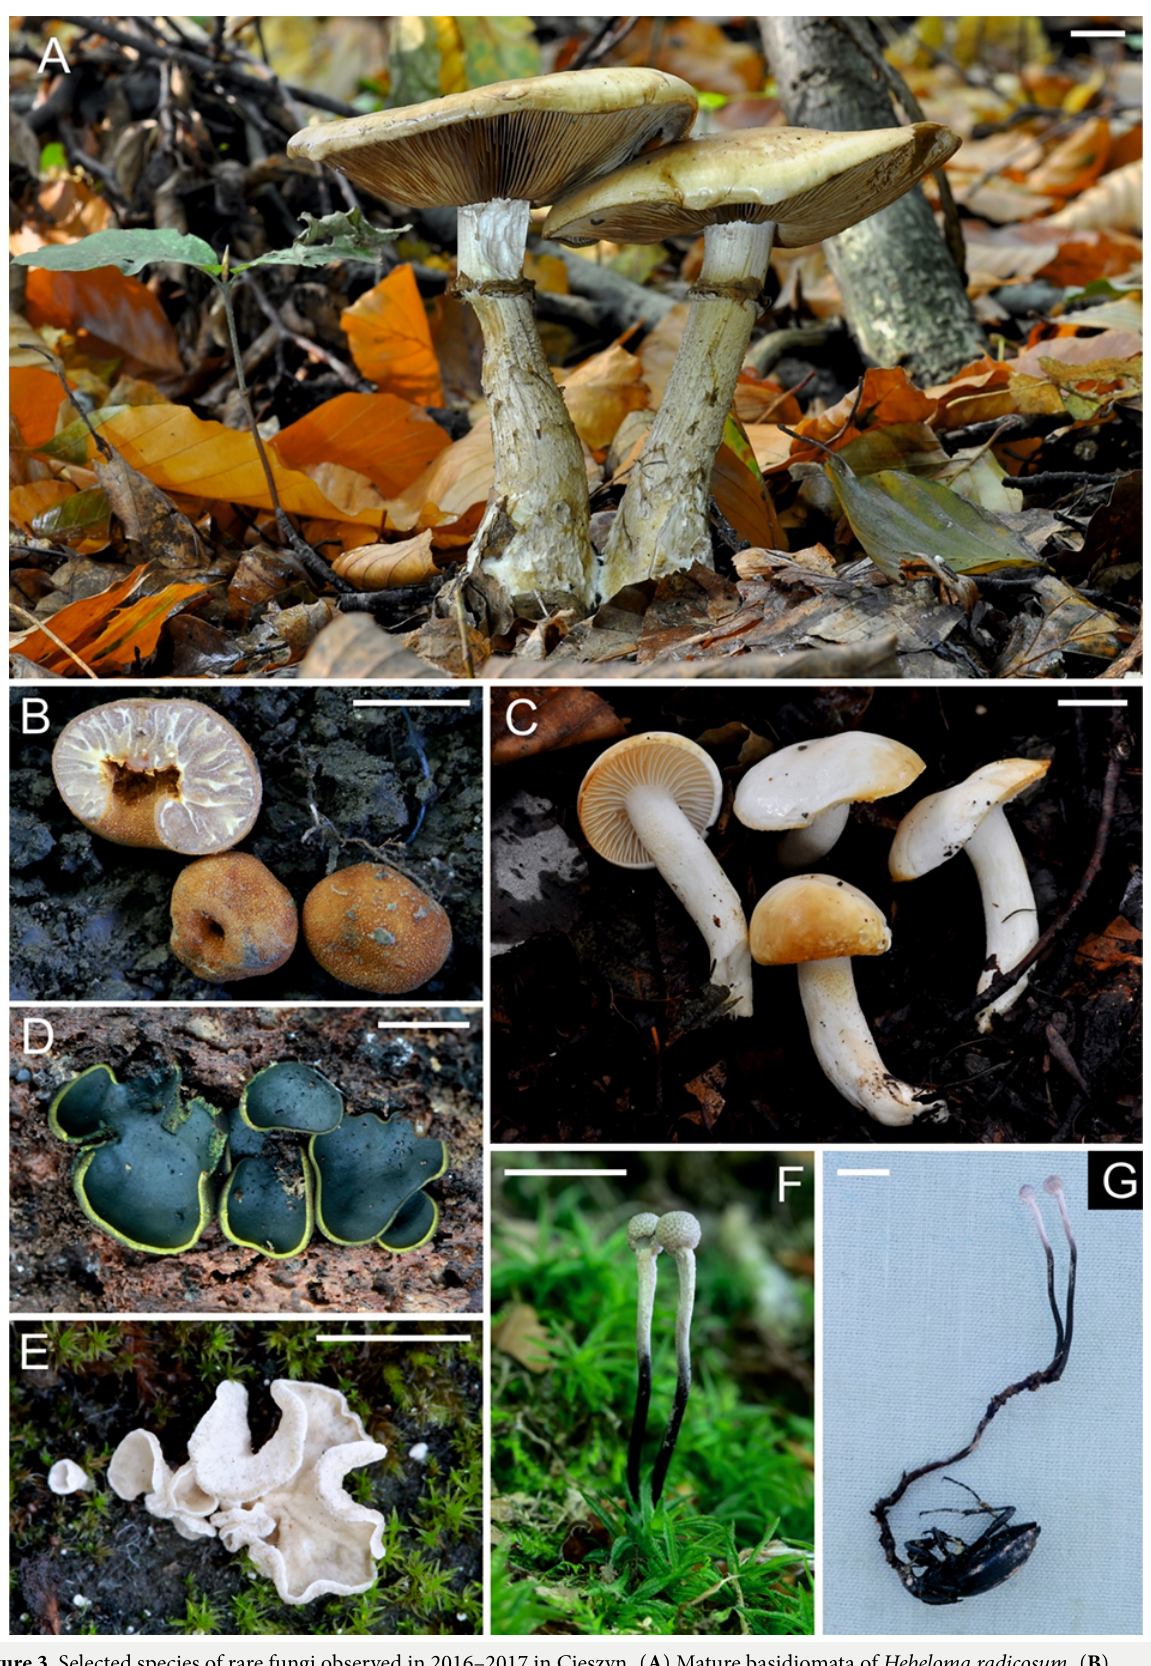
Figure 3 Selected species of rare fungi observed in 2016–2017 in Cieszyn. ( A ) Mature basidiomata of Hebeloma radicosum . ( B ) Ascomata of Tuber fulgens from the outside and in section. ( C ) Basidiomata of Hygrophorus discoxanthus . ( D ) Ascomata of Catinella olivacea . ( E ) Basidiomata of Arrhenia retiruga . ( F,G ) Stromata of Ophiocordyceps entomorrhiza growing from mummified body of Carabus violaceus . Scale bars: 10 mm. Photographs by M. Fiedor ( B,D–G ) and R. Rutkowski ( A,C ).